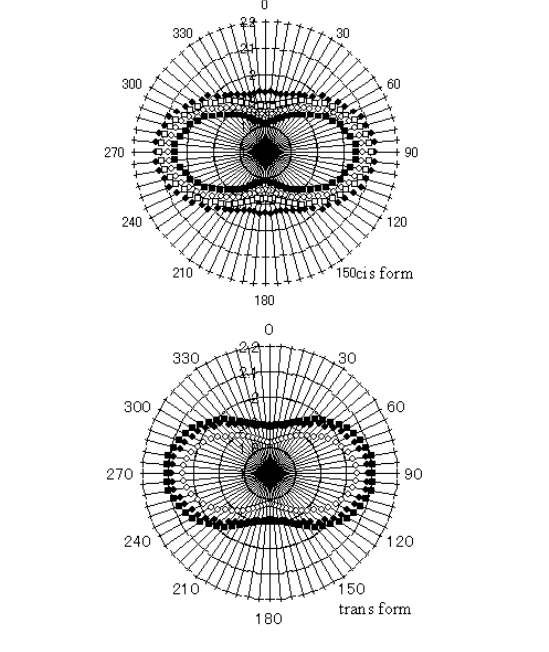
Figure 13. Circular diagram for PMMA-DR1-Mn for [above] cis form and [below] trans form (symbols as in Fig. 10).